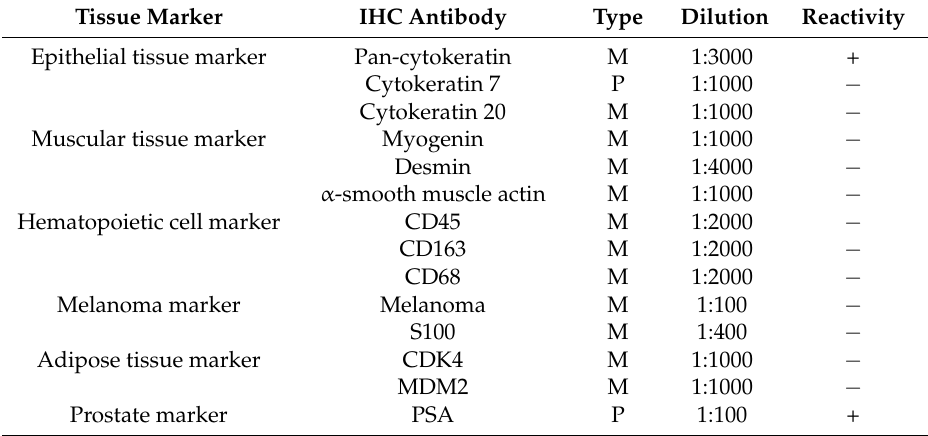
Table 1. Antibodies used for immunohistochemistry.